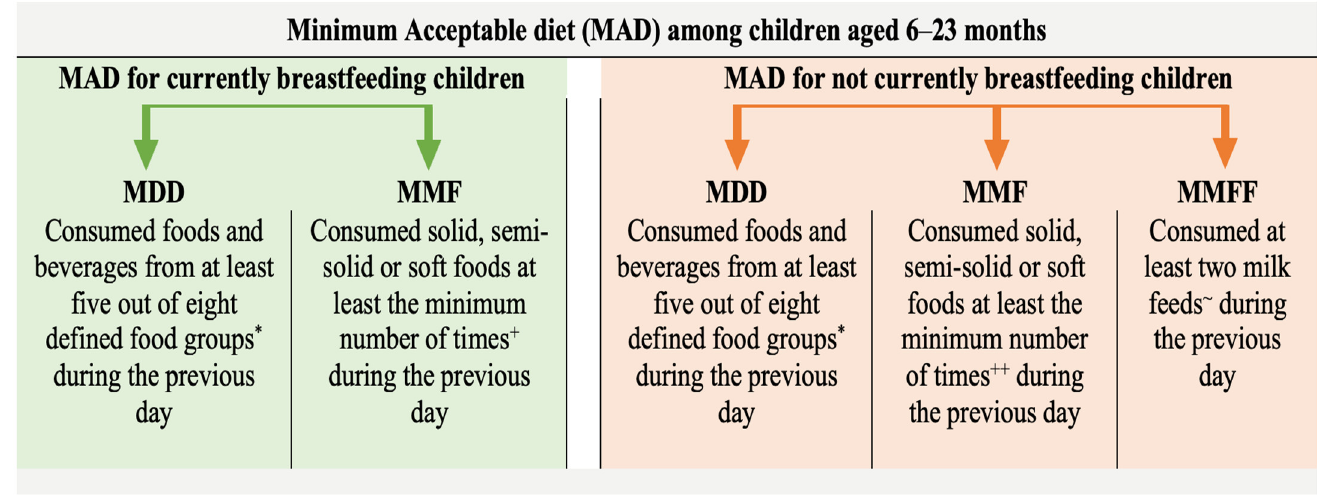
Figure 1. Diagrammatic representation of the definition of minimum acceptable diet. MDD: Minimum Dietary Diversity, MMF: Minimum Meal Frequency, MMFF: Minimum Milk Feeding Frequency. * Food groups: (i) Breast milk, (ii) Grains, roots, tubers and plantains, (iii) Pulses, nuts and